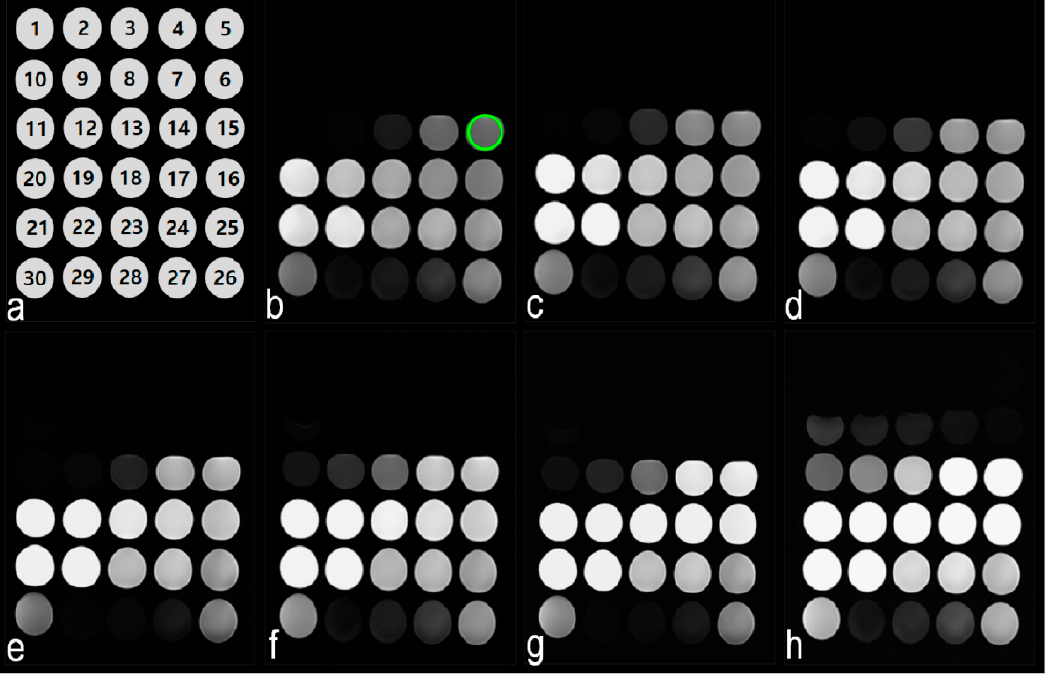
Figure 4. Phantom study images. ( a ) MR phantom container numbers; ( b ) changes in GBCA SI for a 25 msec TE; ( c ) changes in GBCA SI for a 22 msec TE; ( d ) changes in GBCA SI for a 19 msec TE; ( e ) changes in GBCA SI for a 16 msec TE; ( f ) changes in GBCA SI for a 13 msec TE; ( g ) changes in GBCA SI for a 10 msec TE; ( h ) changes in GBCA SI for a 7 msec TE. MR, magnetic resonance; GBCA, gadolinium-based contrast agent; SI, signal intensity; TE, echo time.